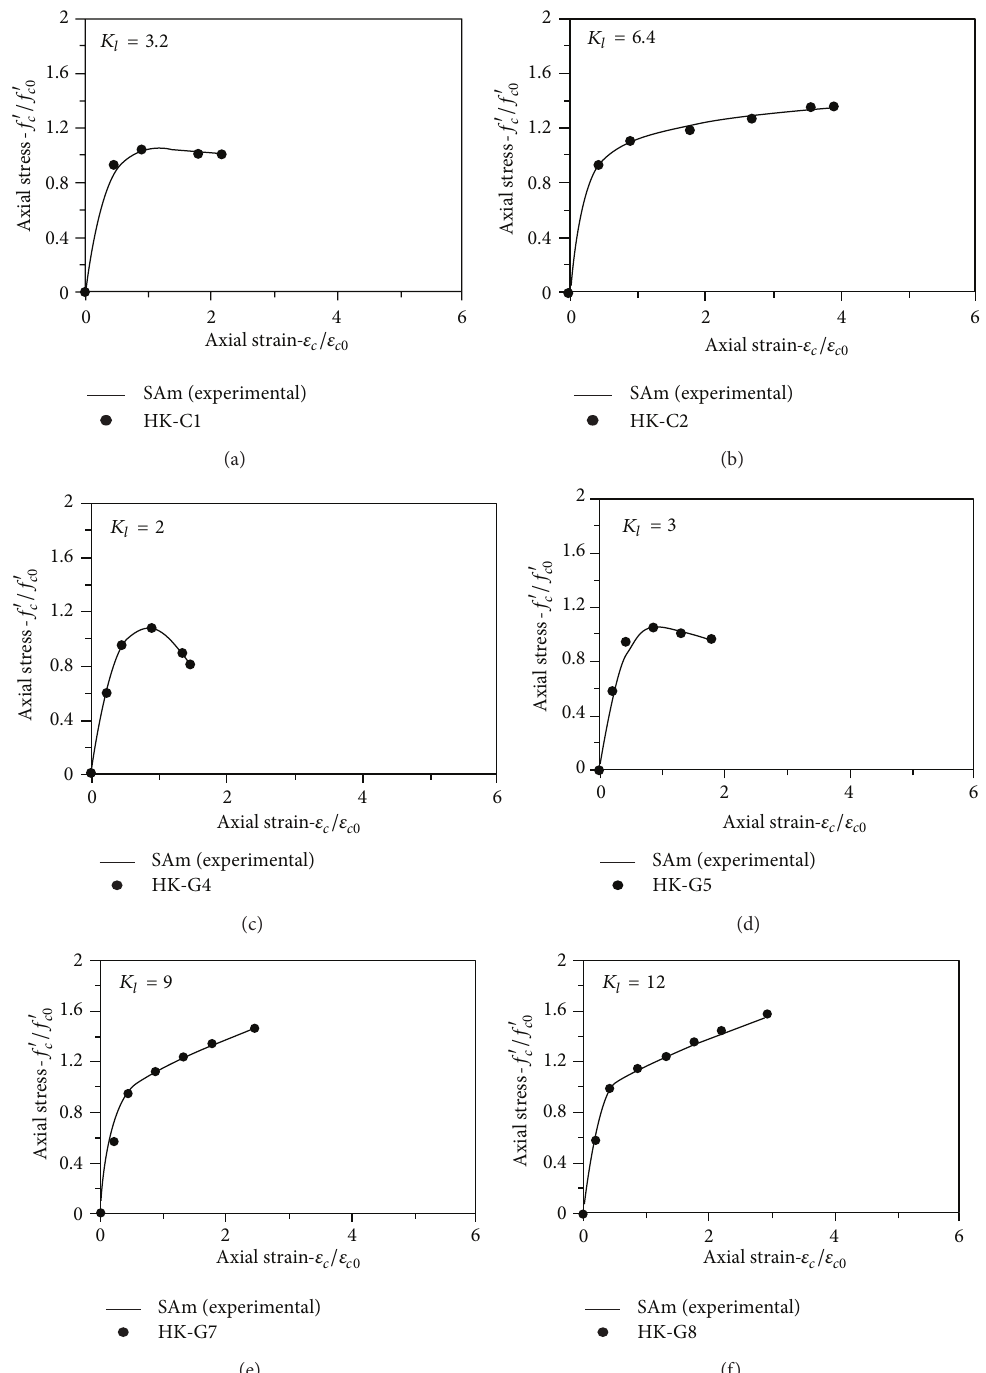
Figure 5: Stress-strain relationship: comparison of analytical results of Sargin’s modified models (SAm) with experimental results.